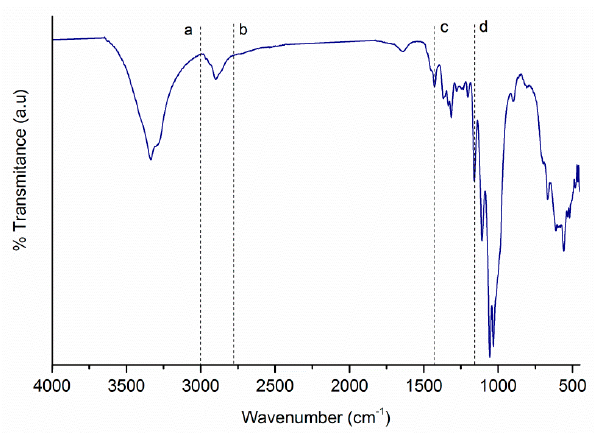
Figure 1. FTIR spectrum of CNCs obtained from acid-hydrolysis of MCC.